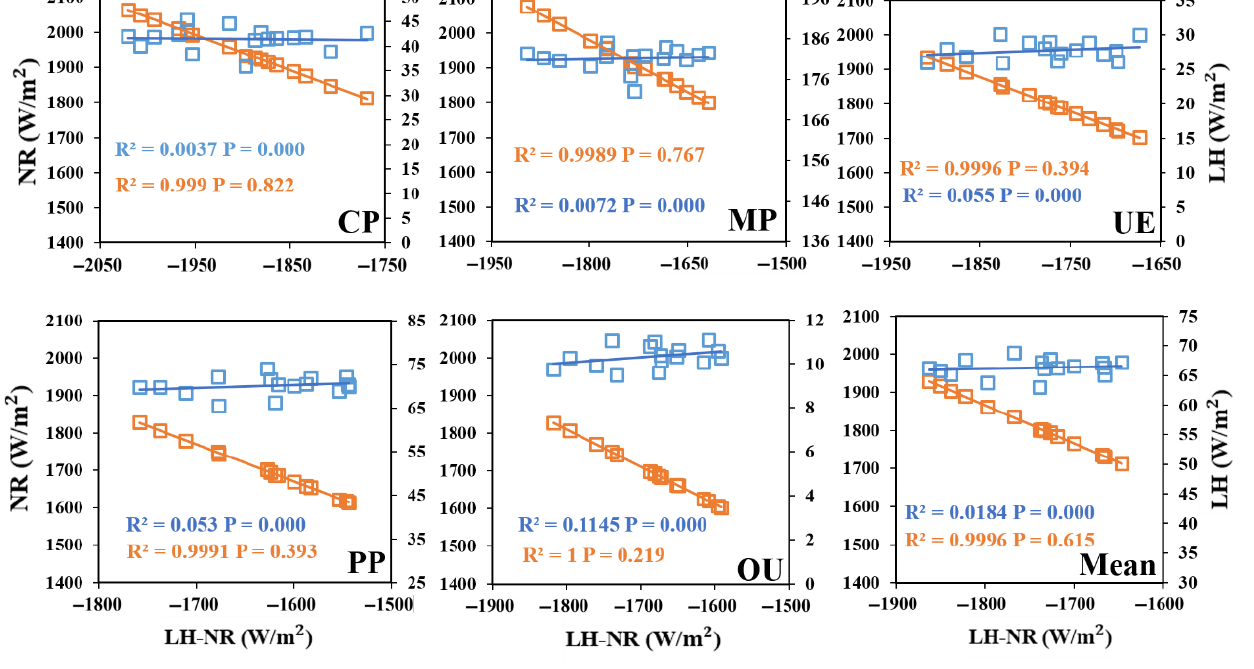
Figure 15. Correlation between and LH, NR and LH–NR under the five land types in the Huang- Huai-Hai River Basin from 2000 to 2015 (blue dots and blue lines represent scatter plots with LH–NR, with LH, orange dots and orange lines represent LH–NR scatter plots with NR).